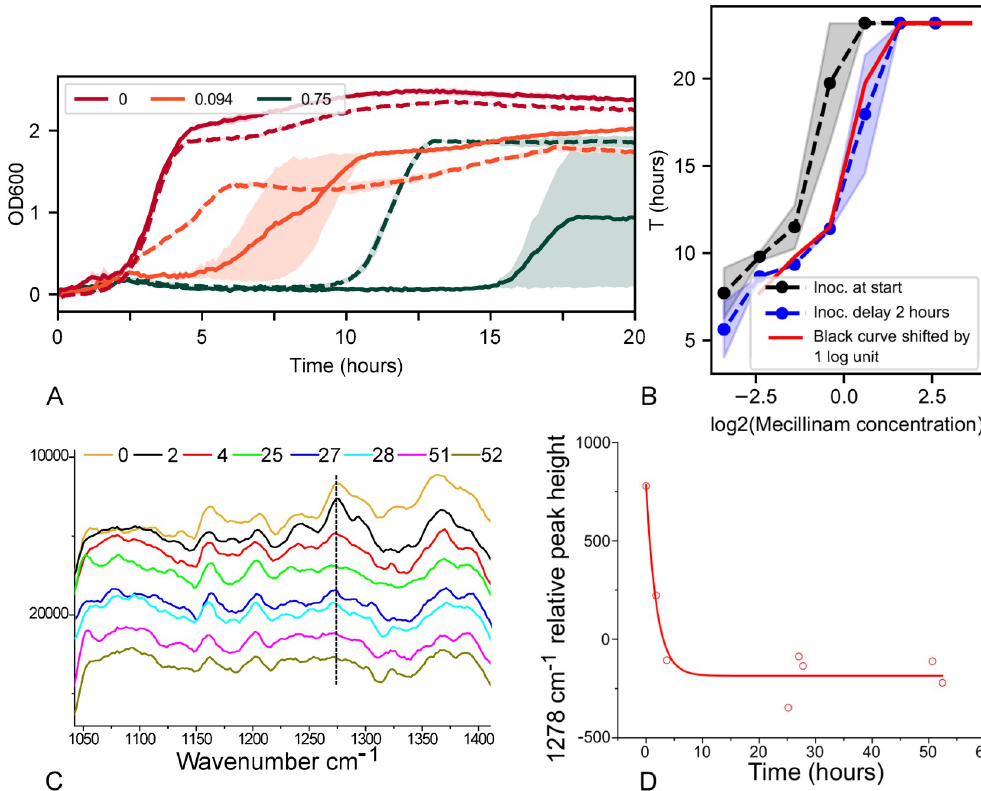
Fig 4. Degradation half-life of mecillinam is approximately 2 hours in MOPSgluRDM at pH 7.4, 37˚C. A: Bioassay measurements: growth curves for E. coli strain RJA002 in MOPSgluRDM at pH 7.4, 37˚C, for cultures inoculated at time zero (solid lines) and after a delay period of 2 hours (dashed lines). The different colours correspond to different (initial) concentrations of mecillinam, as displayed in the legend, in μ g/ml. Only a selection of the concentrations used are displayed to improve the clarity of the plot. B: Bioassay analysis—the time T at which the growth curves reach a threshold OD of 0.75 is plotted as a function of the initial antibiotic concentration. The black data correspond to inoculation at time zero; the blue data to inoculation after a 2 hour delay. The red line shows the black data, shifted by one unit on the log 2 scale; since the blue data falls onto the red line, the degradation half-life is approximately 2 hours. In both panels A and B, the data is averaged over two replicates and the shaded areas represent the standard deviation. C,D: Raman spectroscopy confirms rapid degradation of mecillinam in MOPSgluRDM. C: Raman spectra for the region between 1000 and 1400 wavenumbers, recorded at times 0 to 52 hours (time in hours indicated by colour as shown in the legend). Successive curves are shifted upwards for clarity. D: Relative peak height at 1278 cm − 1 as a function of time is fit to an exponential decay, which gives a half-life of 1.3 ± 0.4 hours. The peak height at 1278 cm − 1 was measured relative to the background spectrum (see